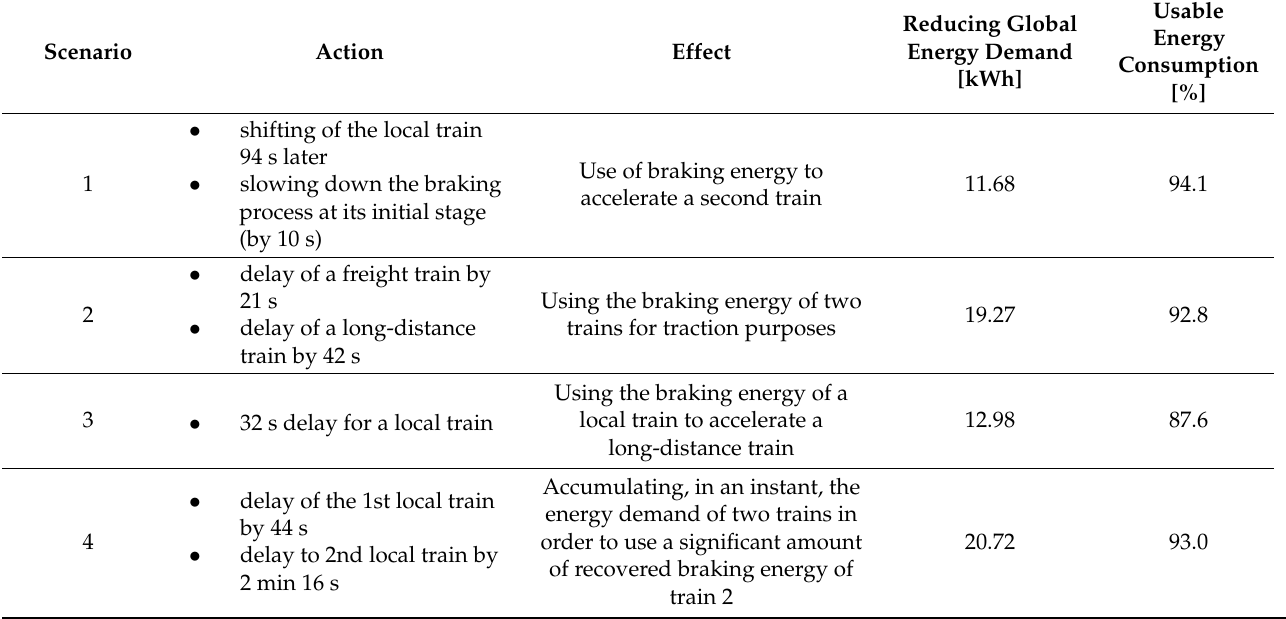
Table 5. Results of the algorithm for the four revealed